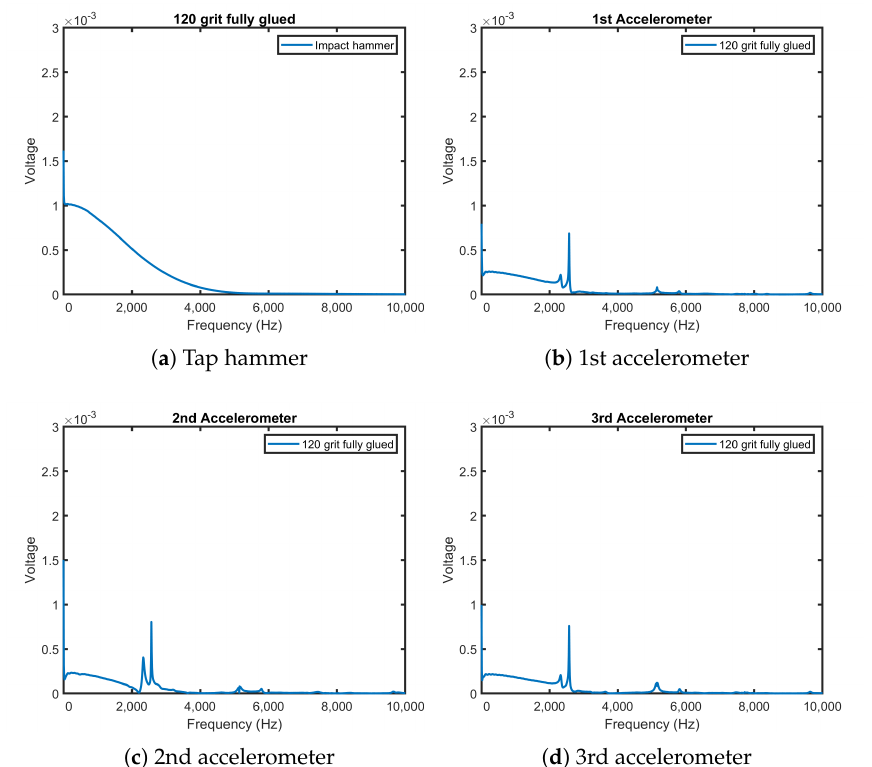
Figure 17. Typical natural frequency result of the fully glued 120 grit wheel.